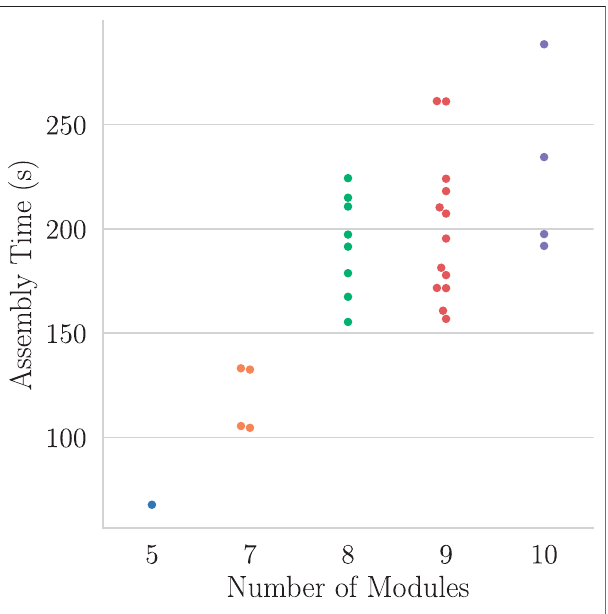
FIGURE 7 | Robot maal assembly time vs. the number of modules. The median time of assembly is 191 s.